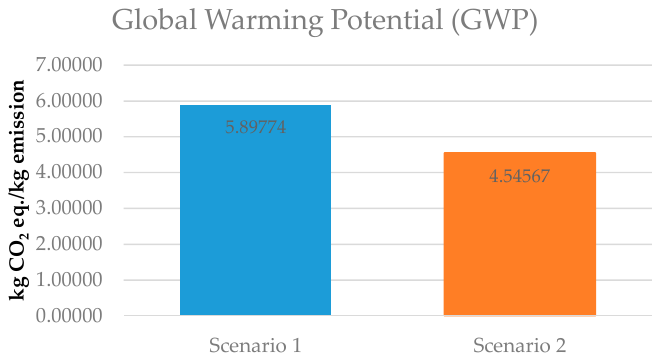
Figure 11. The global warming impact of conventional gasification (scenario 1) and energy self-sufficient gasification (scenario 2).